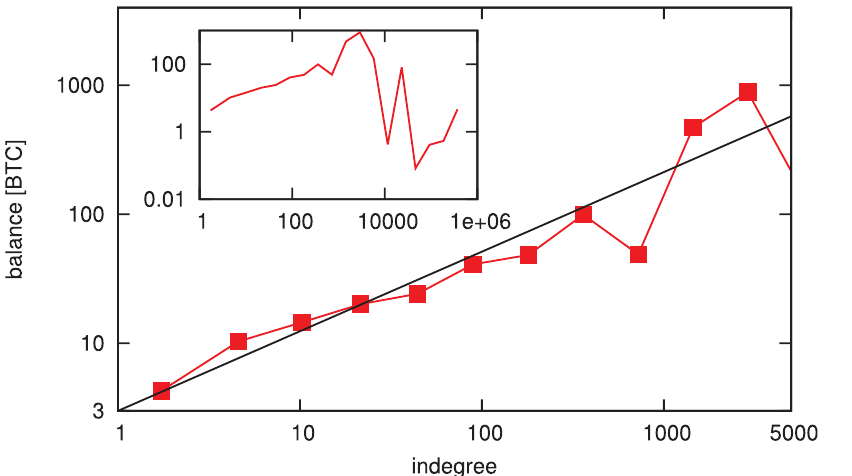
Figure 12. Average node balances as a function of the indegrees. We calculate the averages for logarithmically sized bins. We find strong correlation between the balance and the indegree of individual nodes. The main plot shows indegree values up to k in & 3000 , only 75 nodes ( 0 : 0063 % ) have higher indegree, the averages calculated for such small sample result in high fluctuations (see inset). We also measure both the Pearson and Spearman correlation coefficient: The Pearson correlation coefficient of the full dataset is 0 : 00185041 , while the Spearman rank correlation coefficient is 0 : 275881 . (Note that the Pearson correlation coefficient measures the linear dependence between two variables, while the Spearman coefficient evaluates monotonicity). We test the statistical significance of the correlation by randomizing the dataset 1000 times and calculating the Spearman coefficient for each randomization. We find that the average Spearman coefficient is 10 { 4 with a standard deviation of 9 : 5 : 10 { 4 , indicating that the correlation is indeed significant.